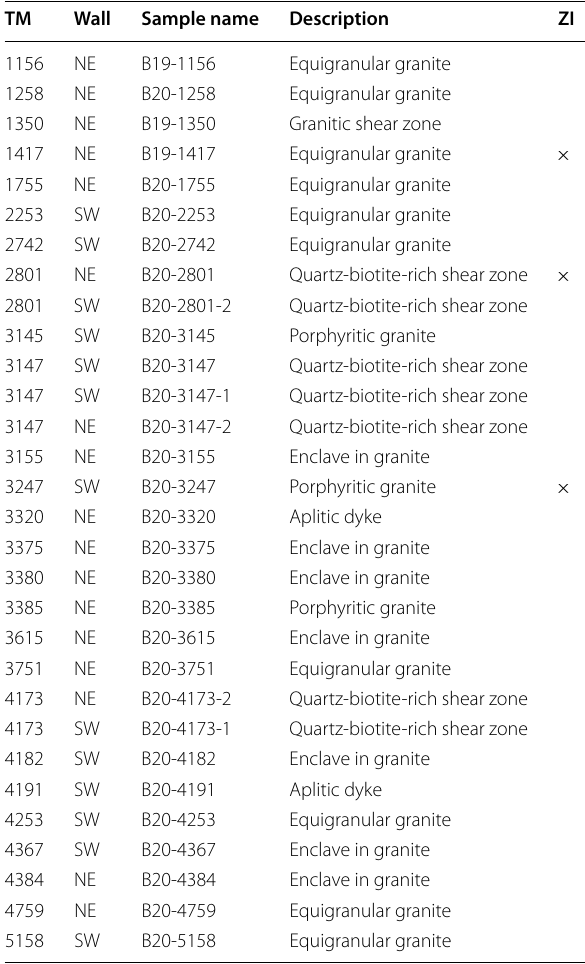
Samples used for zircon investigations are marked with ‘ × ’ in the corresponding column (ZI). The uncertainty in the TM-measurements is about ± 1